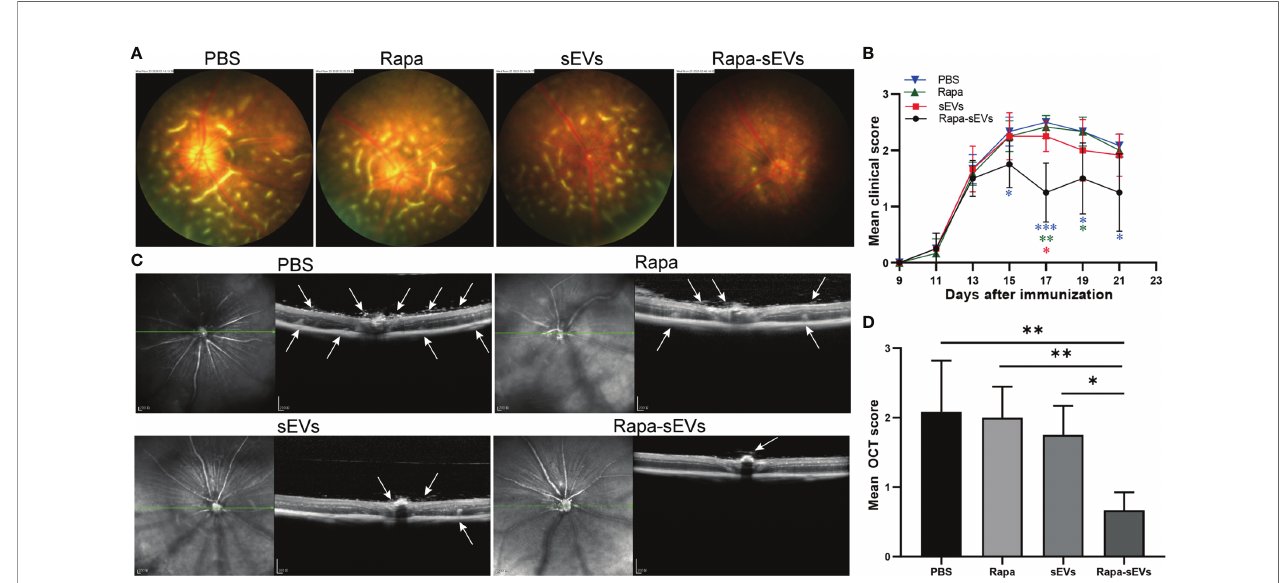
FIGURE 5 | Subconjunctival injection of Rapa-sEVs ameliorated uveitis in mice. Fundus images and OCT at day 18 post-immunization showed ocular in fl ammation in PBS, Rapa, and sEV treated groups (A, C) . In contrast, Rapa-sEV treatment led to decreased ocular in fl ammation (A, C) . (B) Clinical observation of EAU mice treated with PBS, Rapa, sEVs, and Rapa-sEVs. ***P < 0.001, **P < 0.01, *P < 0.5, Kruskal-Wallis test (D) OCT was performed at day 18 post-immunization, and results are expressed quantitatively as OCT scores. The in fl ammatory cells in the vitreous, retinal folders, and retinal detachment near the optic disk were indicated by white arrows. Values are expressed as the mean ± SD of six mice (6 eyes) per group. **P < 0.01, *P < 0.5, Kruskal-Wallis test.